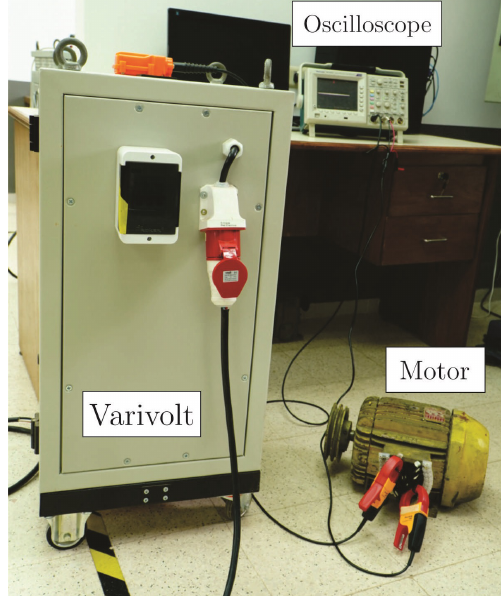
Figure 9. Experimental platform of the modified nine-phase IM.